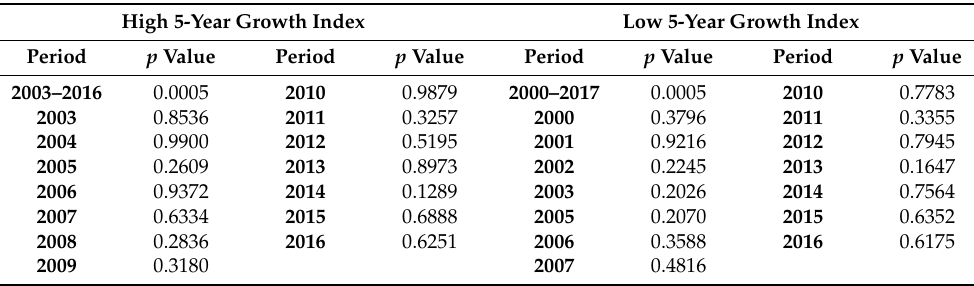
Table 12. Anderson–Darling test results ( p values)—growth